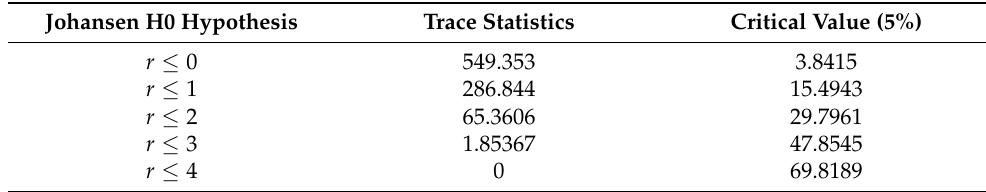
Figure 9. Transformed test data through fitting curves.